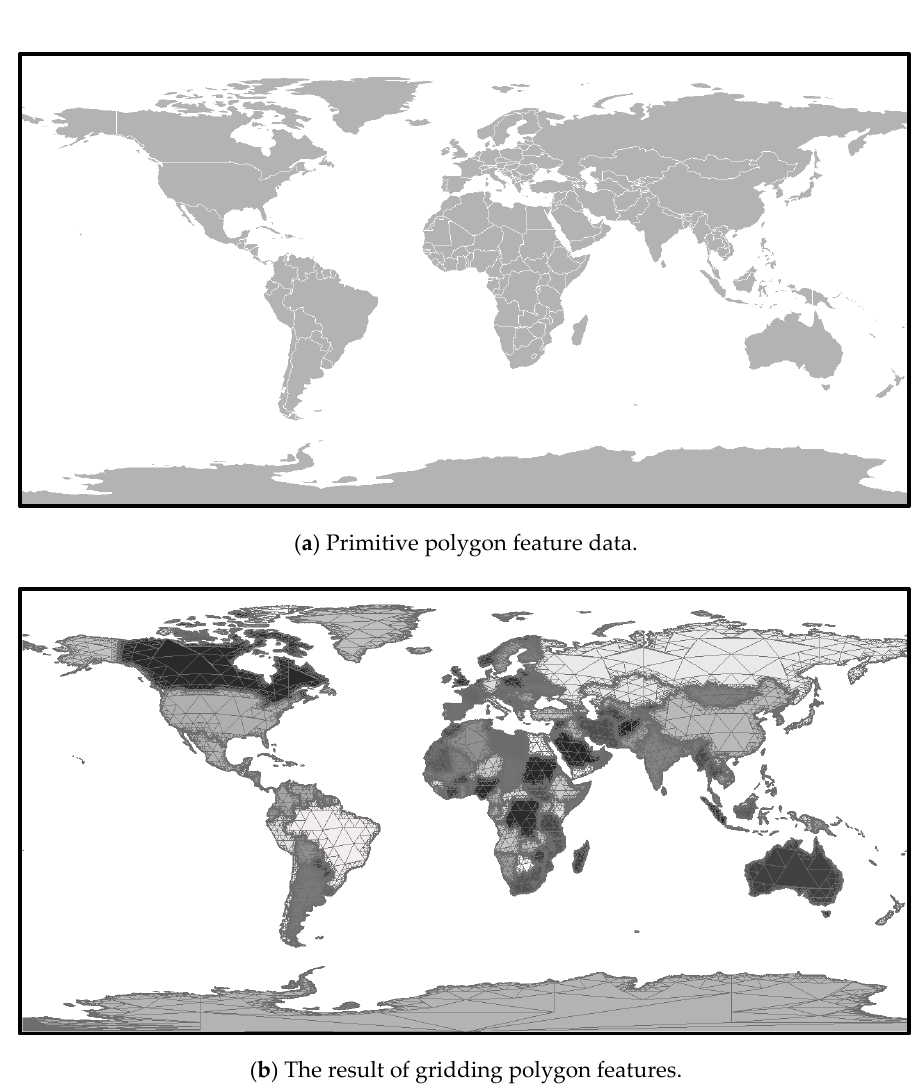
Figure 13. Polygon feature data and gridding result.